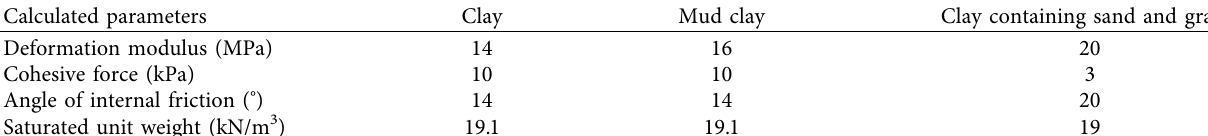
Table 1: Physical and mechanical parameters of rock